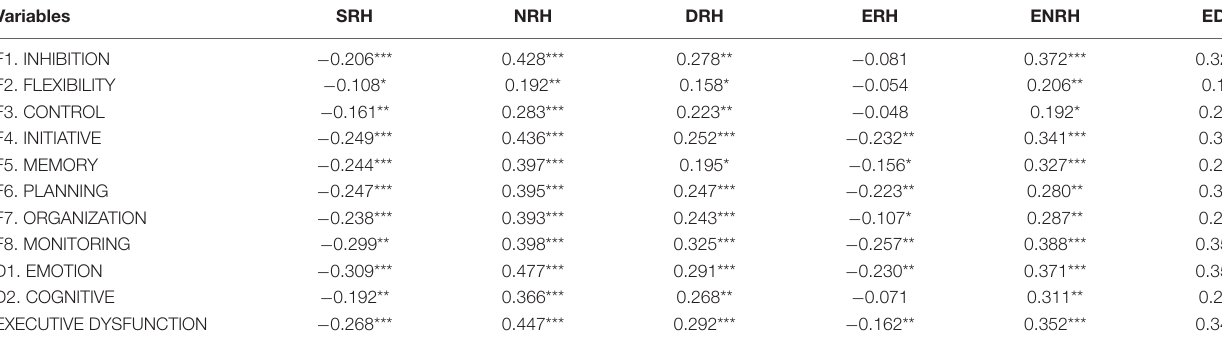
TABLE 4 | Bivariate correlations between self vs. external regulation (SR-ER) and difficulties inherent to executive functions (EFs). Variables SRH